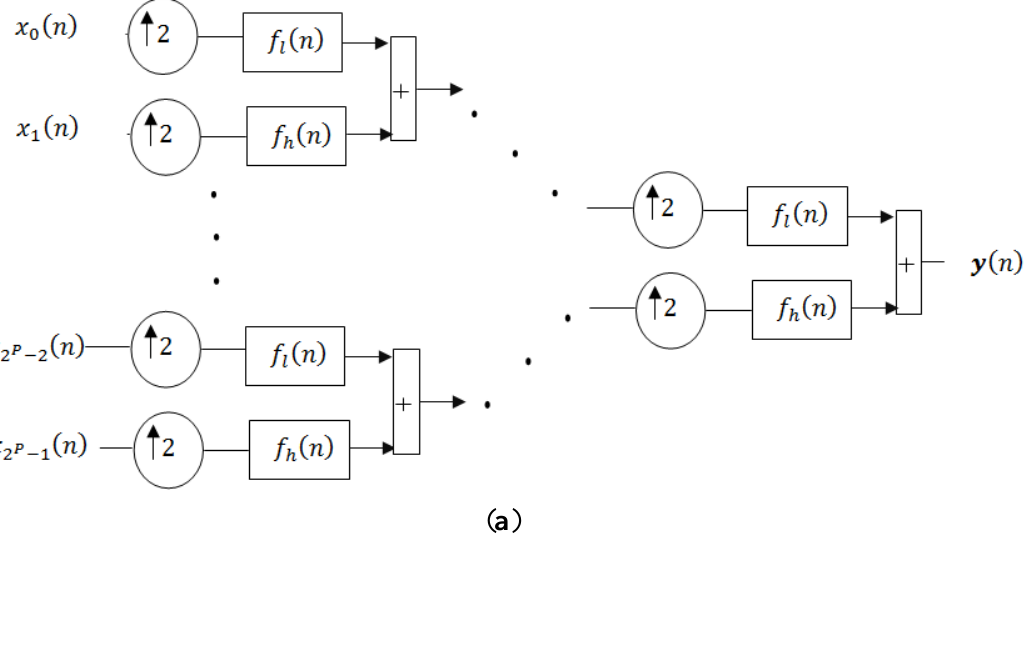
Figure 2. By using symmetric structure, the orthonormal wavelets are given by the following equation: